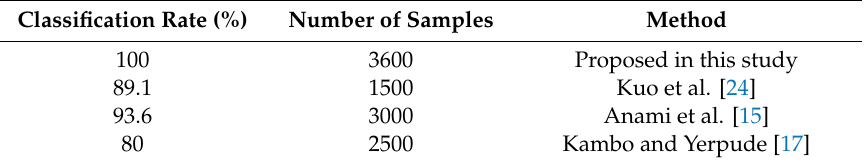
Table 7. Comparison of the accuracy of the proposed method with other